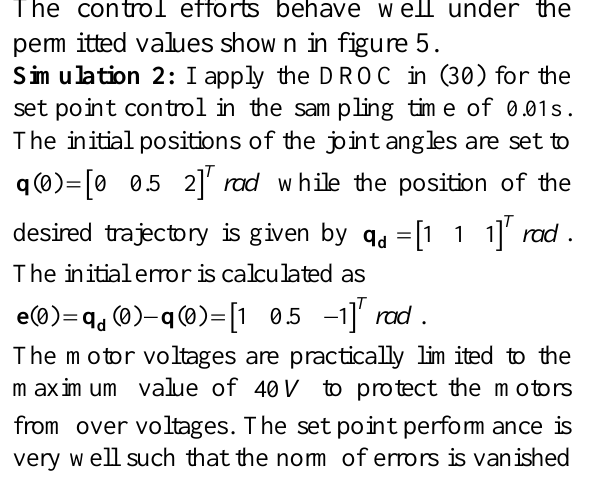
Figure 1. Tracking performance of DROC in the sampling time of 0.001s .